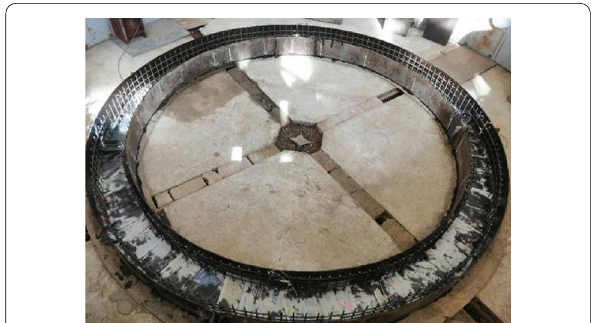
C E = C f = 1, C ρ = 1, C ξ = 1. = C = 1, C C σ X